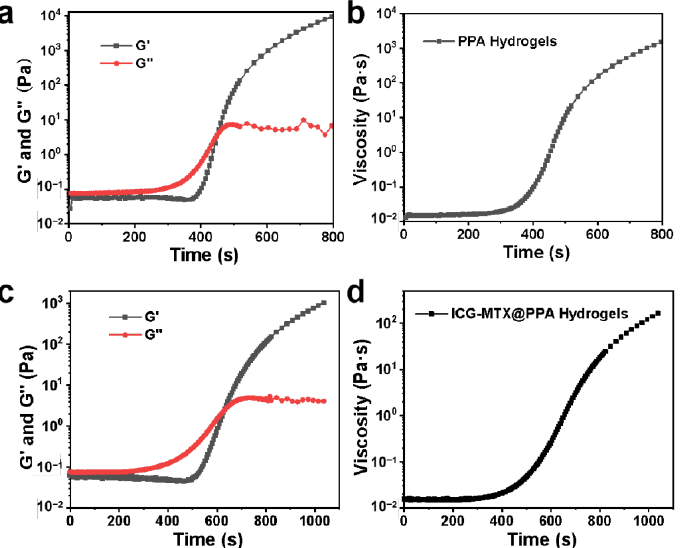
Figure 7. ( a ) The storage modulus (G ′ ) and loss modulus (G ″ ) of PPA Gels vary with time. ( b ) The viscosity of PPA Gels varies with time. ( c ) The storage modulus (G ′ ) and loss modulus (G ″ ) of ICG — Polymers 2022 , 14 , x FOR PEER ICG—MTX@PPA Gels vary with time. ( d ) The viscosity of ICG—MTX@PPA Gels varies with time.